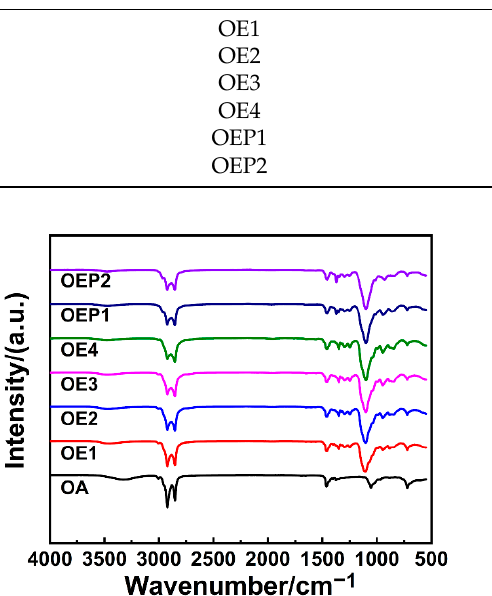
Figure 1. Chemical structure of the prepared defoamers. Table 1. Structure list of the prepared defoamers.